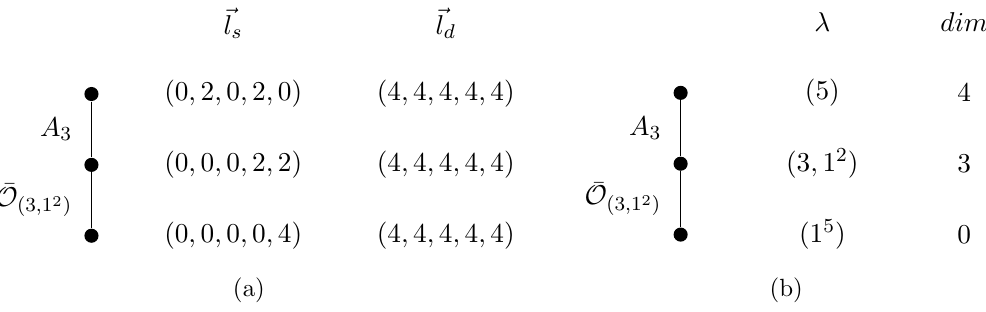
Figure 41. Hasse diagram for the models whose Higgs branch is the closure of a special nilpotent orbit of so (5) under the adjoint action of the group O (5). (a) represents the brane con(cid:12)gurations, where the linking numbers ~l s and ~l d are provided for each orbit and the rightmost orientifold plane is always of type O 3 (cid:0) . (b) depicts the information of the orbits. (cid:21) is the partition obtained from the interval numbers ~k s as discussed above. dim is the number of physical D3-branes that generate the Higgs branch in each